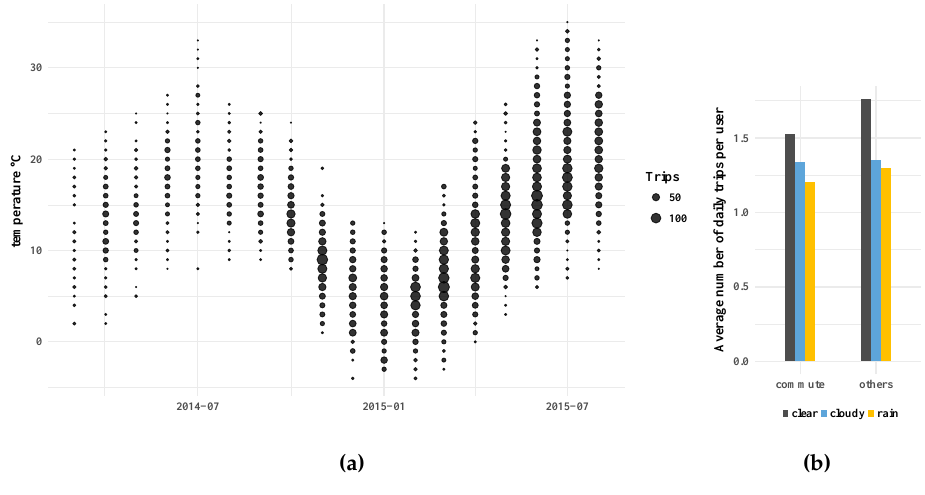
Figure 4. Weather conditions fro sampled trips: ( a ) number of trips and temperature; ( b ) commute trips and other types of trips.